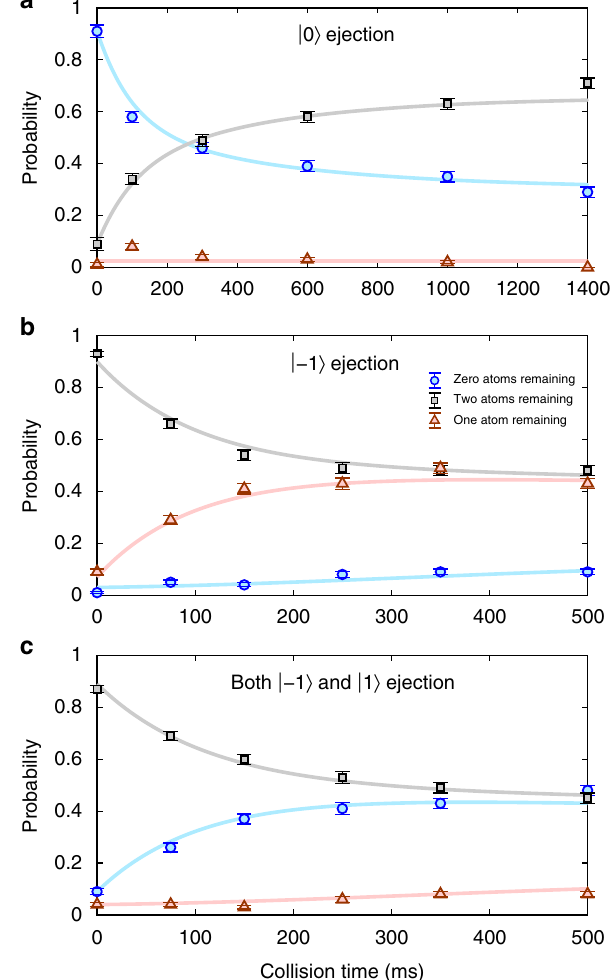
Fig. 2 m -state correlation results. Probability that zero, one, or two atoms remain in the optical tweezer after a given collision time. a When atoms in |0 〉 are expelled (immediately after a given collision time), the probability that both atoms were in |0 〉 (and therefore ejected) decreases, while the probability that both atoms remain correspondingly increases. b , Expelling atoms solely from | − 1 〉 gives only single-atom loss events. c , Expelling atoms from both | − 1 〉 and |1 〉 gives only pair loss, in strong contrast to the result in b . In all cases and throughout the collision time, the bias magnetic fi eld was 8.5 Gauss. Error bars in all panels denote the standard error of the mean. The solid curves are fi ts to the data included to guide the eye. Similar data that demonstrates correlations between | − 2 〉 and | + 2 〉 is shown in Supplementary Fig. 1. Source data are provided as a Source Data fi